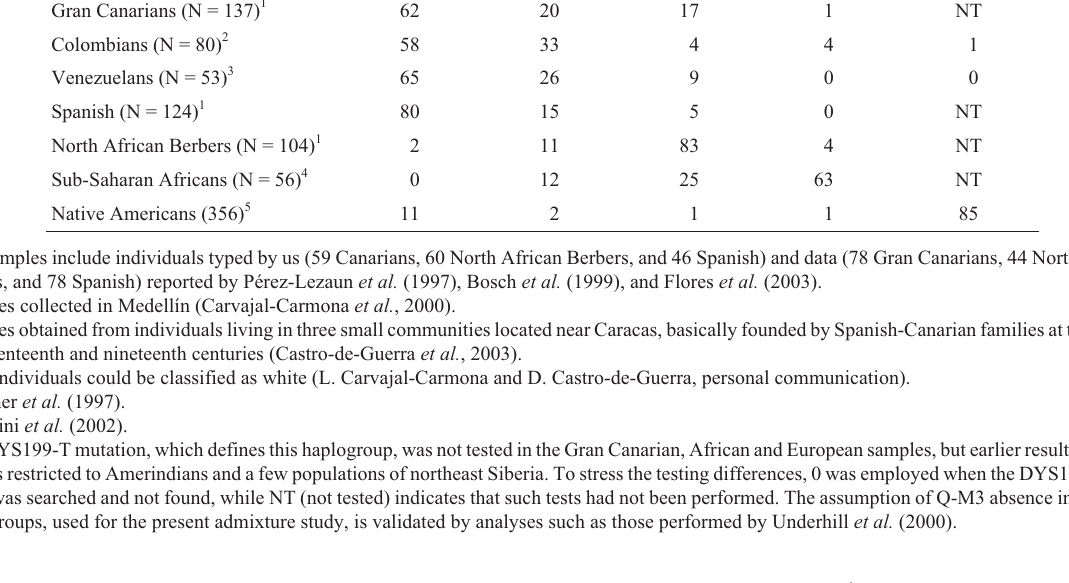
Gran Canarians (N = 137)